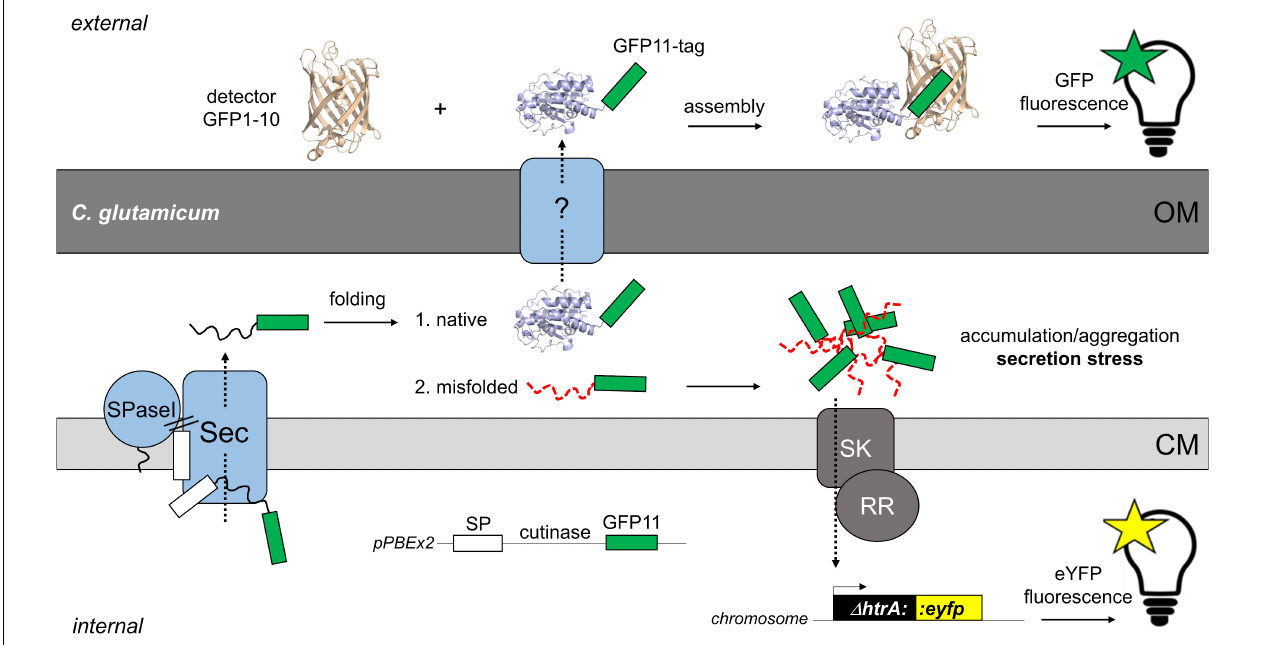
FIGURE 1 | Fluorescence-based monitoring of Sec-secretion stress in C. glutamicum and detection of secreted target protein by the split GFP assay. The overproduction of secretory proteins promotes accumulation of incompletely or misfolded proteins at the membrane-cell envelope interface. To alleviate this secretion stress, cells typically respond by the upregulation of the extra-cytoplasmic protease HtrA, which is able to degrade the misfolded proteins at the trans -side of the cytoplasmic membrane (CM). In C. glutamicum , a two-component system consisting of a sensory kinase (SK) and a response regulator (RR) is likely involved in regulation of expression of the adjacent htrA gene (Jurischka et al., 2020). In the C. glutamicum K9 biosensor strain, the htrA gene has been replaced by the eyfp gene, while leaving the htrA signal transduction pathway intact. The fluorescent reporter strain allows the monitoring of Sec-dependent secretion of recombinant proteins in a dose-dependent manner (Jurischka et al., 2020). The actual mechanism(s) and protein systems facilitating the transport of proteins across the mycolic acid outer membrane (OM) of C. glutamicum still remain an enigma. For detection of the target protein in the extracellular medium, we adapted the split GFP technology (Cabantous et al., 2005; Cabantous and Waldo, 2006) that previously had been adopted to monitor recombinant protein secretion in B. subtilis (Knapp et al., 2017). For this purpose, the eleventh β -sheet of GFP, is fused via a flexible linker to the C-terminus of the target protein (in our studies the model enzyme cutinase). The non-fluorescent detector GFP, which lacks eleventh β -sheet (GFP1-10) is produced separately in E. coli and purified from inclusion bodies. Combining the GFP11-tagged protein with the detector GFP1-10 enables reconstitution of functional fluorescent GFP. Subsequent measurement of the split GFP fluorescence allows detection and quantification of the secreted target protein. The white box indicates the signal peptide (SP); the green box indicates the GFP11-tag; SPase, signal